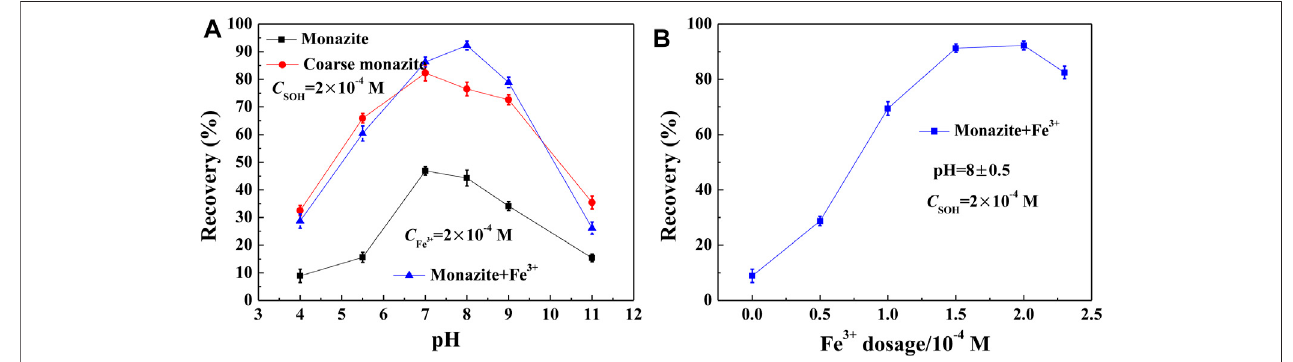
FIGURE4| MonaziterecoverywithSOHasafunctionof (A) pHand (B) Fe 3+ dosage.(Coarsemonaziterefersto – 74+38 μ mfractions,whilemonaziterepresents – 26 + 15 μ m fractions.)